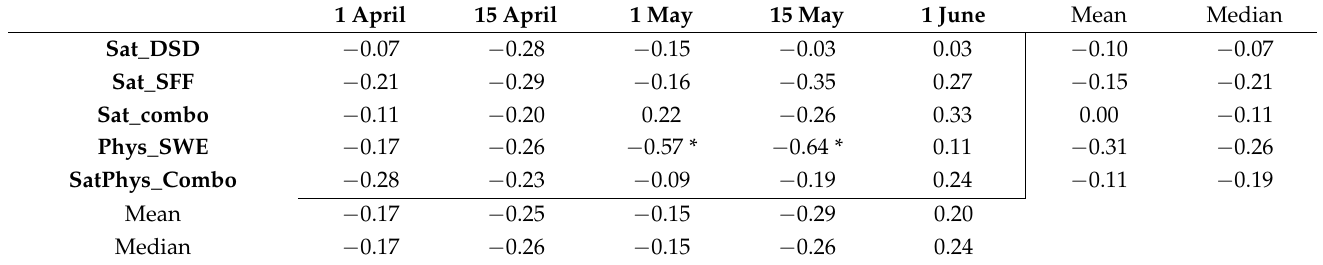
Table 4. Correlation between SWE/P ratio and median PBIAS values for all basins calculated for each model and each forecast date. Values with a significant relationship ( p -value < 0.05) are marked with an